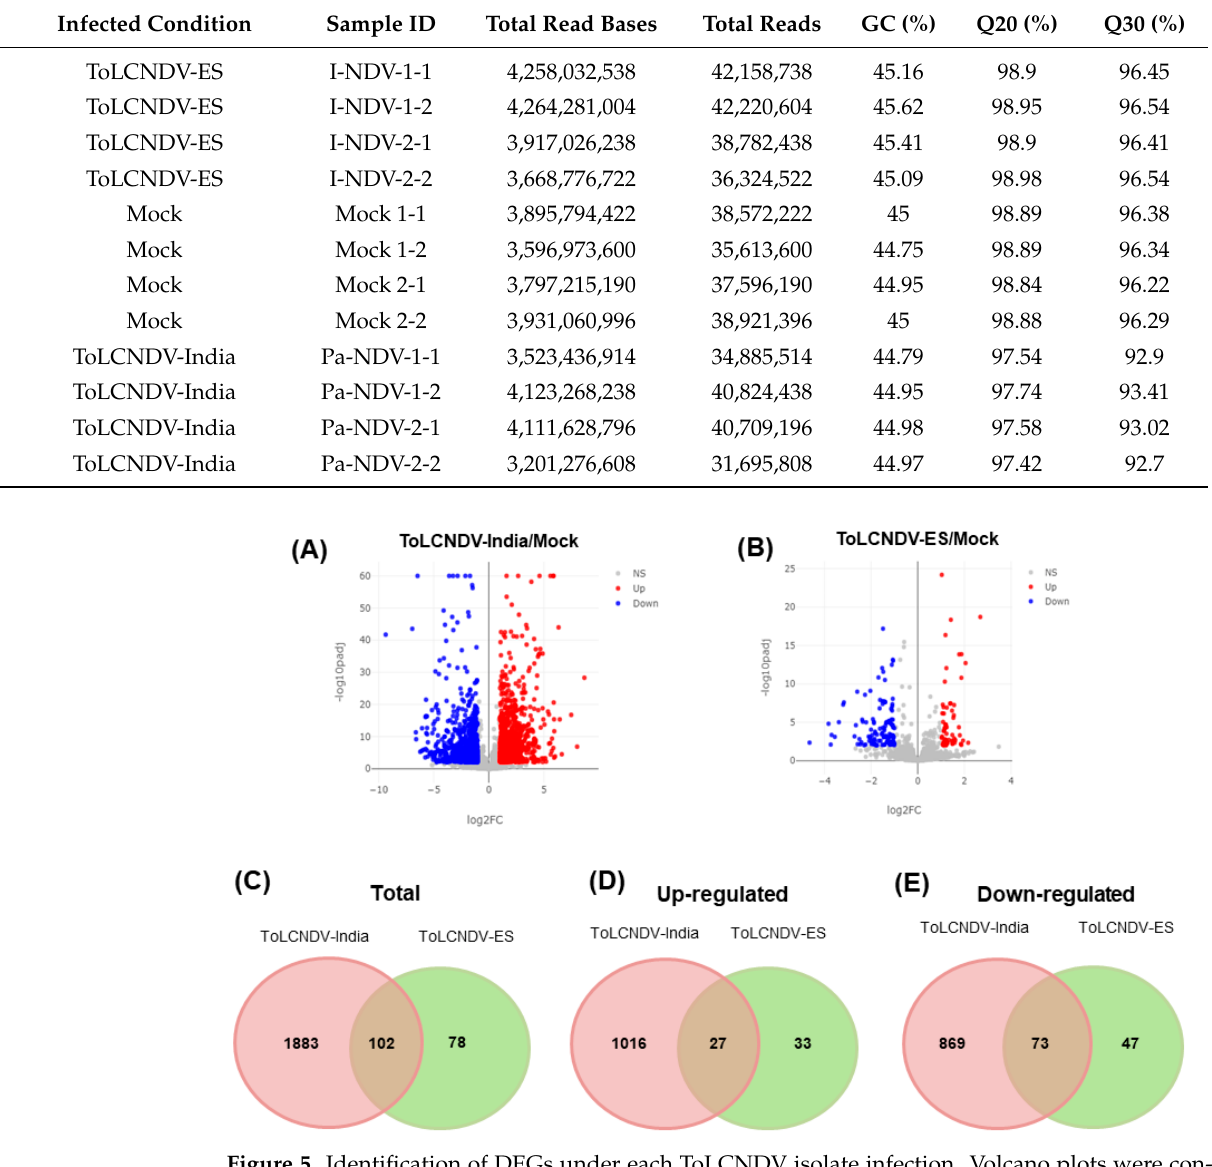
Table 2. Summary of the raw data generated by sequencing of the three groups (mock, ToLCNDV- India, and ToLCNDV-ES).